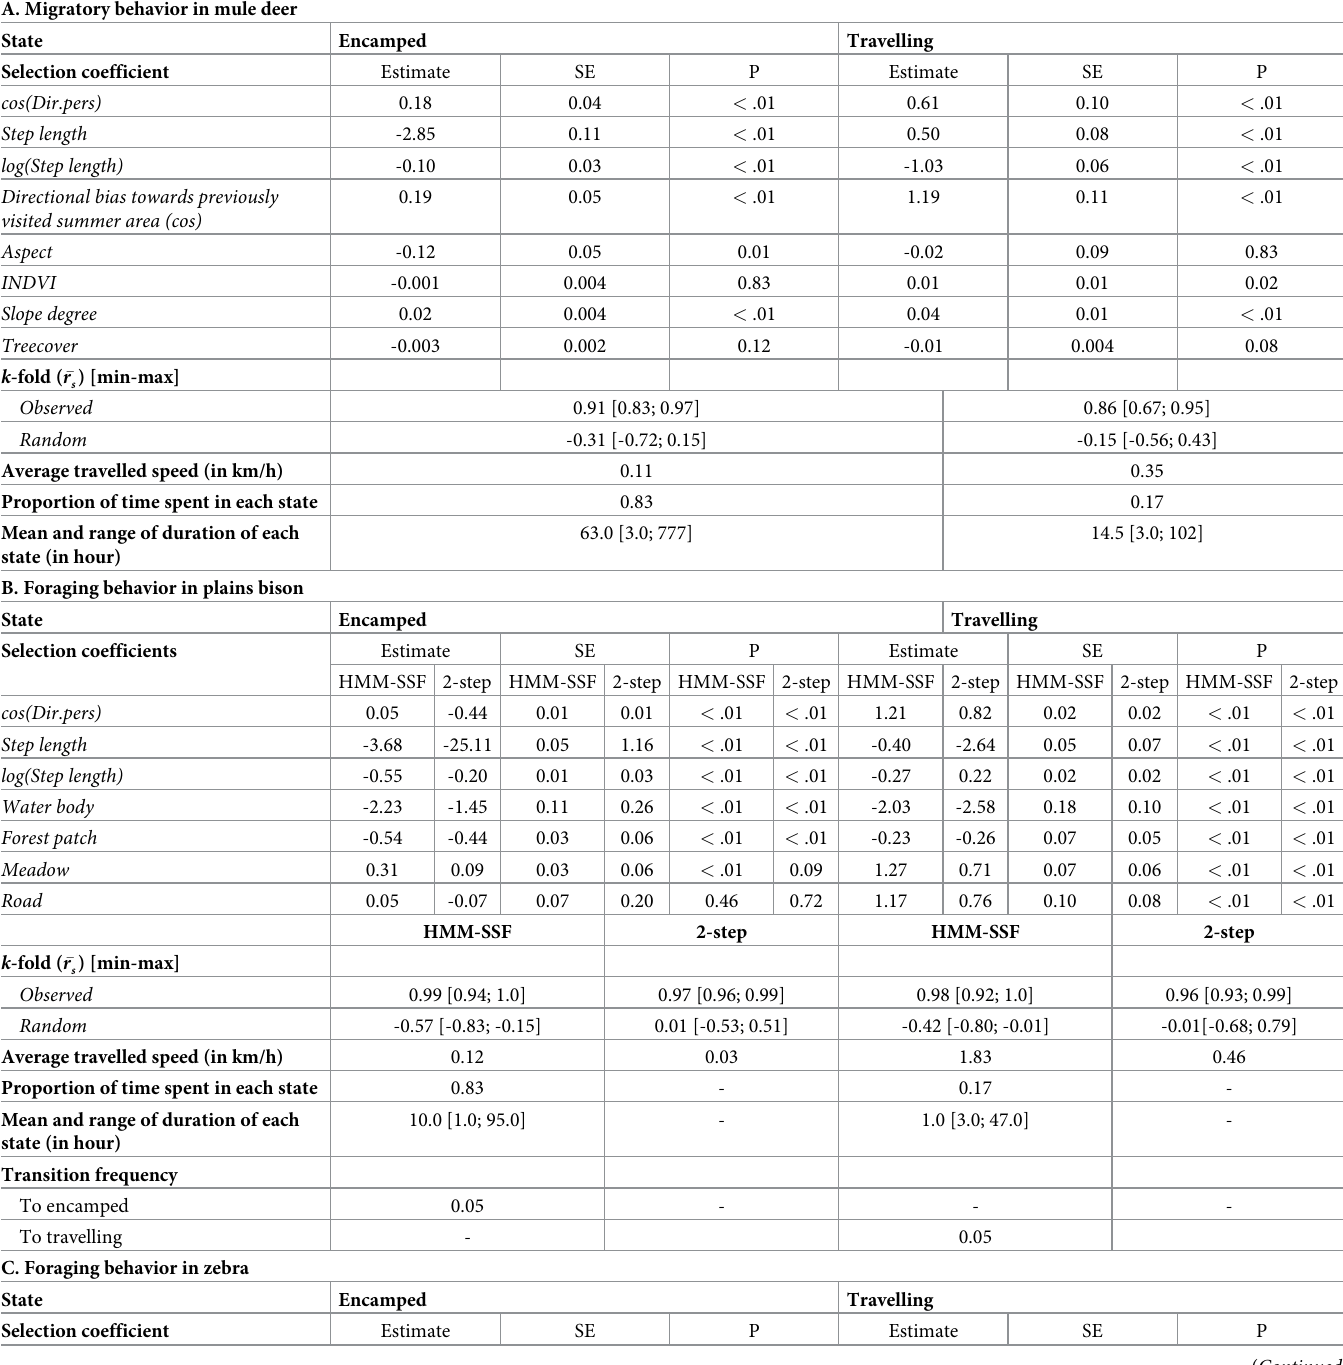
Table 3. State-specific selection coefficient estimates along with their standard-error (SE) and associated P-value (P) of the HMM-SSF used to predict animal move- ments according to encamped or travelling mode, in three ecological systems. A. Habitat selection during the different phases of the migratory behavior, B. and C. Hab- itat selection during the different phases of the foraging behavior. Estimates of model parameters from a 2-step approach are also shown for the bison dataset (B). Analysis were performed using 13,444, 94,686 (50592 for the 2-step approach) and 72,730 geolocations from 15 mule deer, 42 plains bison and 18 zebras over 2 (2011–2012), 11 (2005–2016) and 3 (2012–2014) years of monitoring, respectively. The predictive capabilities of the HMM-SSF and the 2-step approach (B) were assessed using k -fold vali- dation repeated 100 times, means and ranges of Spearman rank correlation ( � r ) are reported for each behavioral mode of movement and both observed and random steps. s Average travelled distances were calculated using step length and log-transformed step length coefficient estimates (see S1